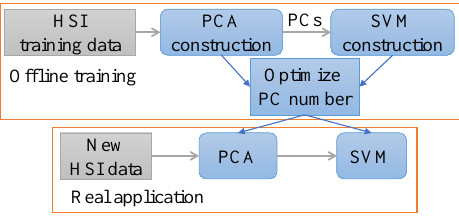
Figure 20. Flowchart of the PCA aided SVM for HSI